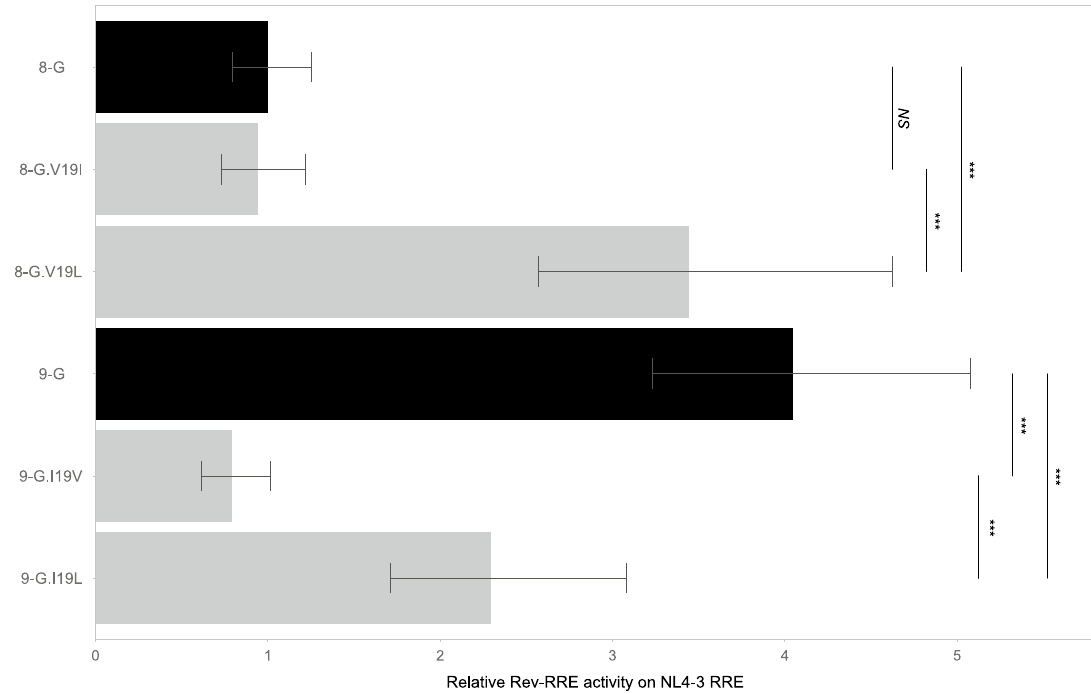
Figure 8. Activity of position 19 mutants on NL4-3 RRE. Revs with amino acid substitutions at position 19 were created and their functional activity determined on the NL4-3 RRE using the fluorescence-based assay system. The native 8-G and 9-G Rev sequences are included in dark bars for reference and modified Revs are in light bars. Relative activity is expressed in arbitrary units with the activity of the 8-G Rev/NL4-3 RRE pair defined as 1. The statistical comparison is performed between the Revs indicated by the vertical bars. N ≥ 3 for all data points, error bars represent 95% CI. NS —not significant, *** p <